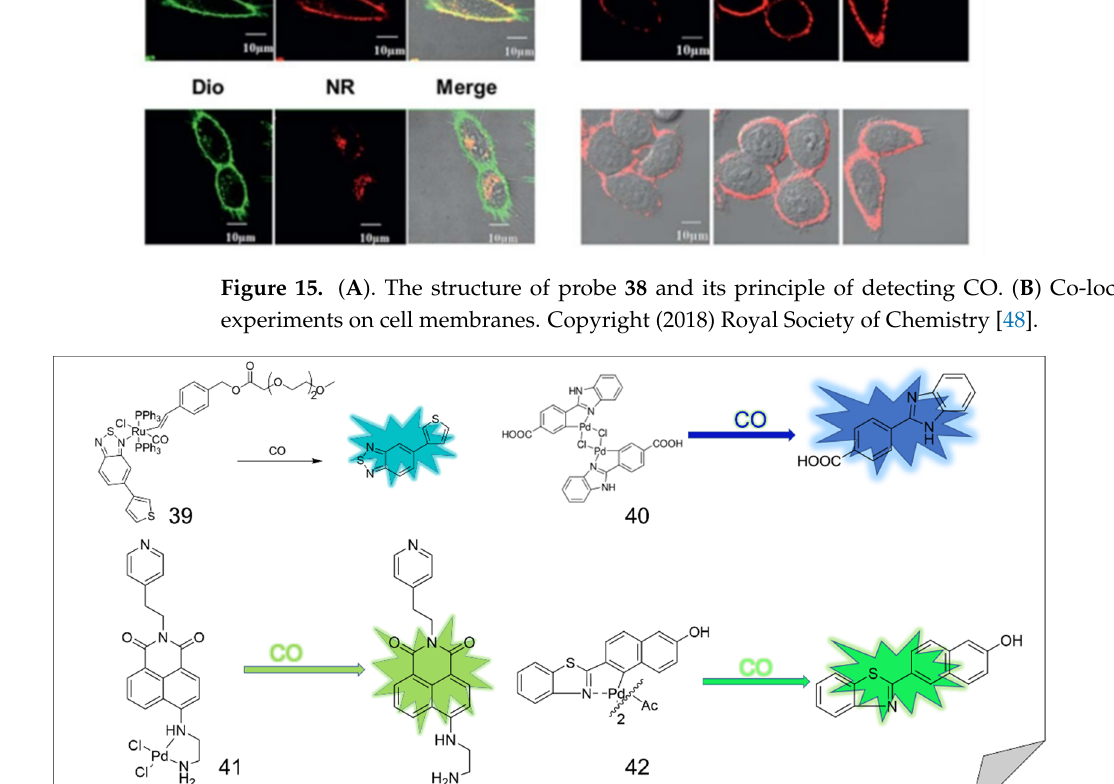
Figure 16. Other fluorescent probes for the detection of CO and their sensing mechanisms based on palladium metal-mediated carbonylation or protonation hydrolysis reactions. palladium metal-mediated carbonylation or protonation hydrolysis